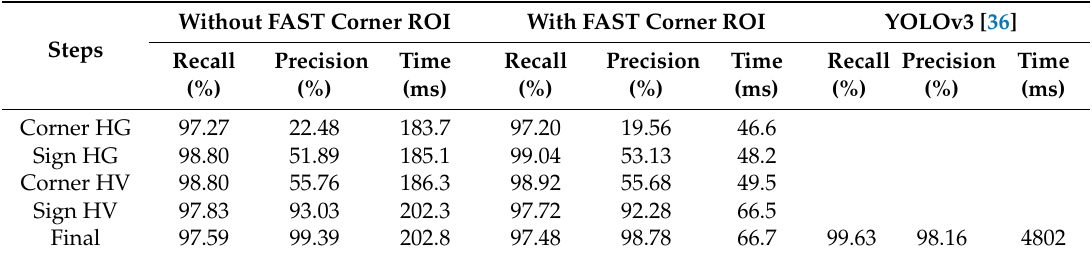
Table 3. Experimental